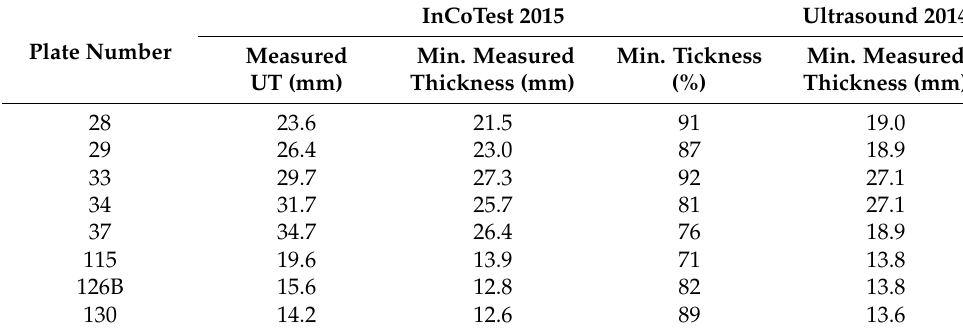
Table 3. Results of the Insulated Component Test